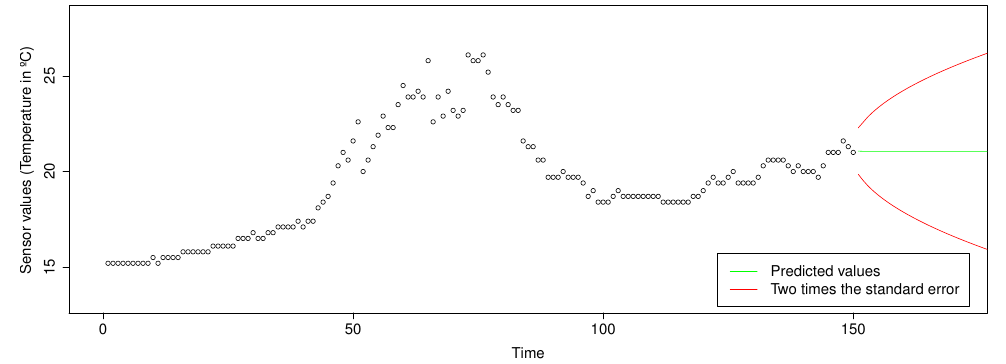
Figure 4. Temperature measurements up to sample 150. The green line represents the predictions made by an ARIMA model, and the lines in red are twice the standard